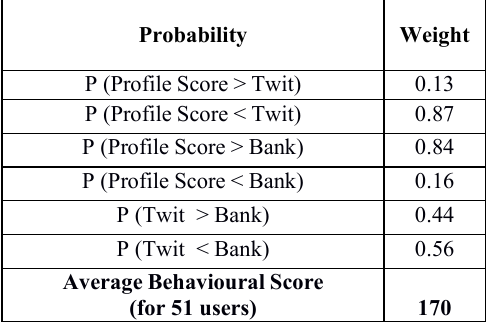
Table 7. Pairwise Comparison